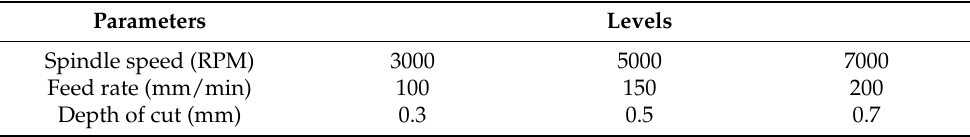
Table 3. Parameters and levels used in the experiments.